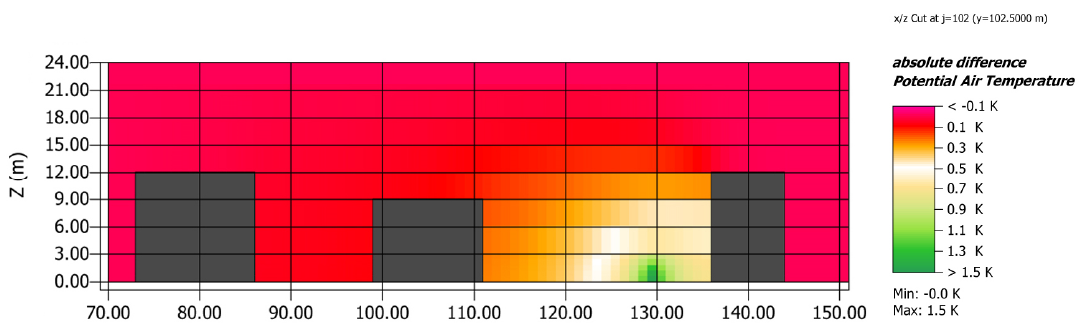
Figure 6. The difference of air temperature between the absolute current state and the reference water curtain scenario in the cross cut; view in north direction. Figure by authors.